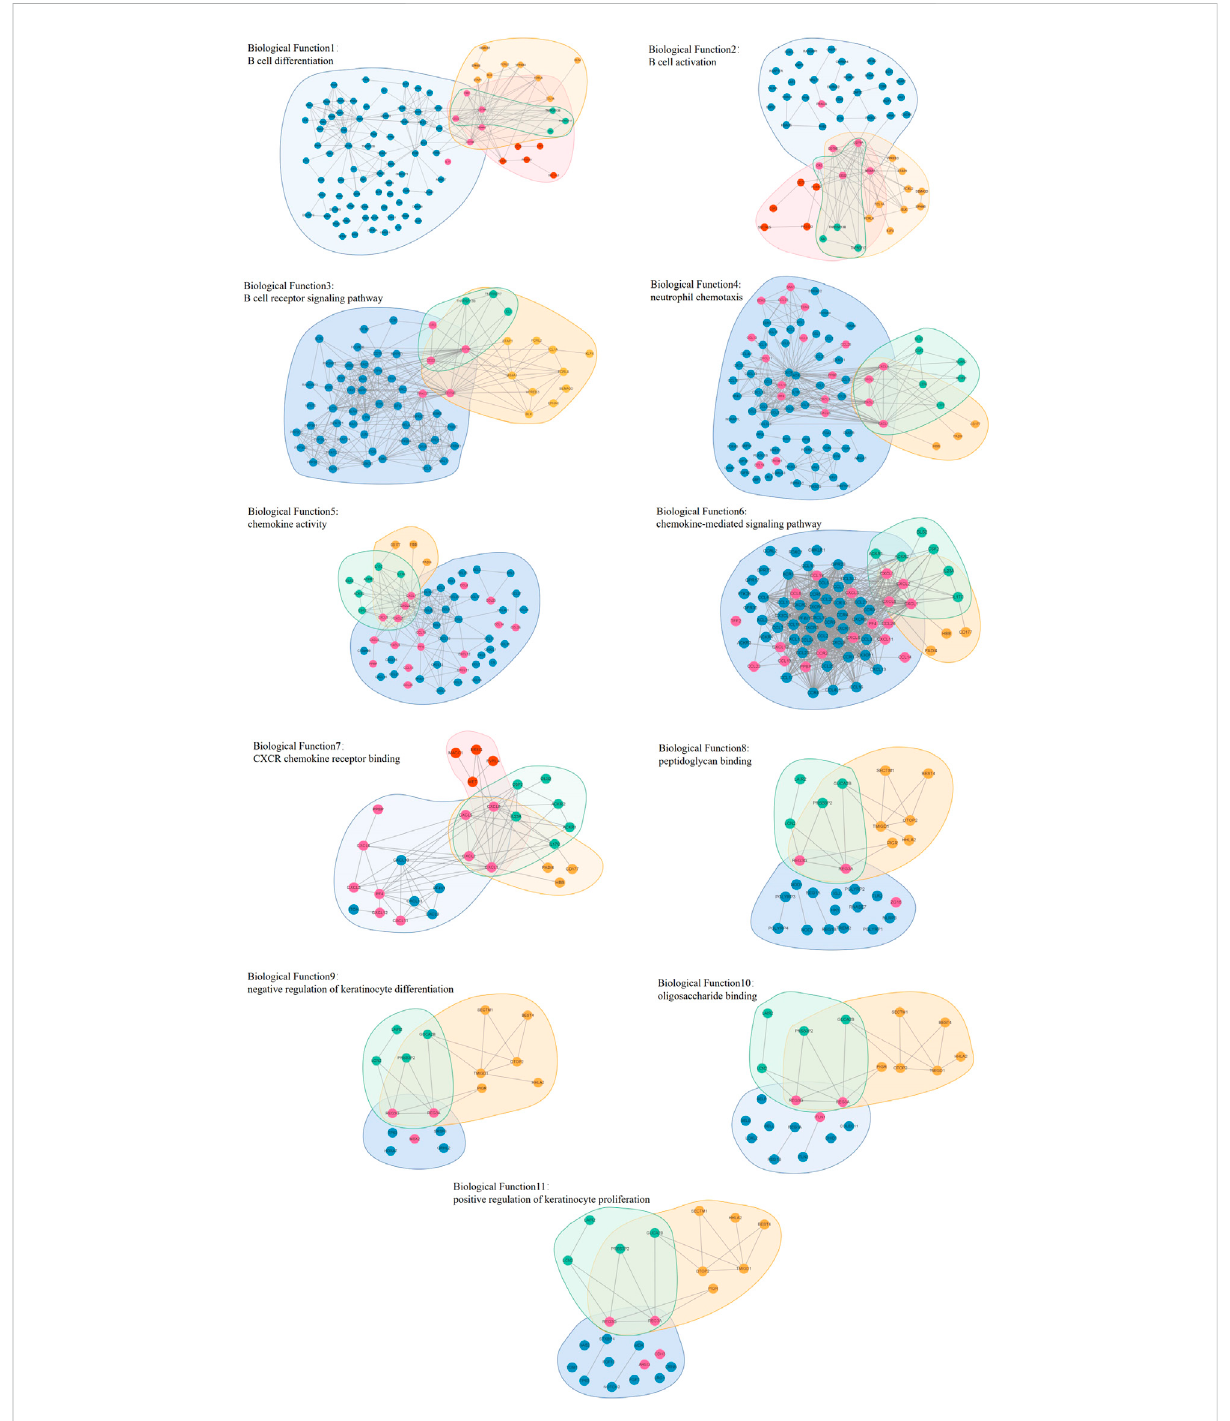
FIGURE 13 Graphs (11) visualizing the biological functions